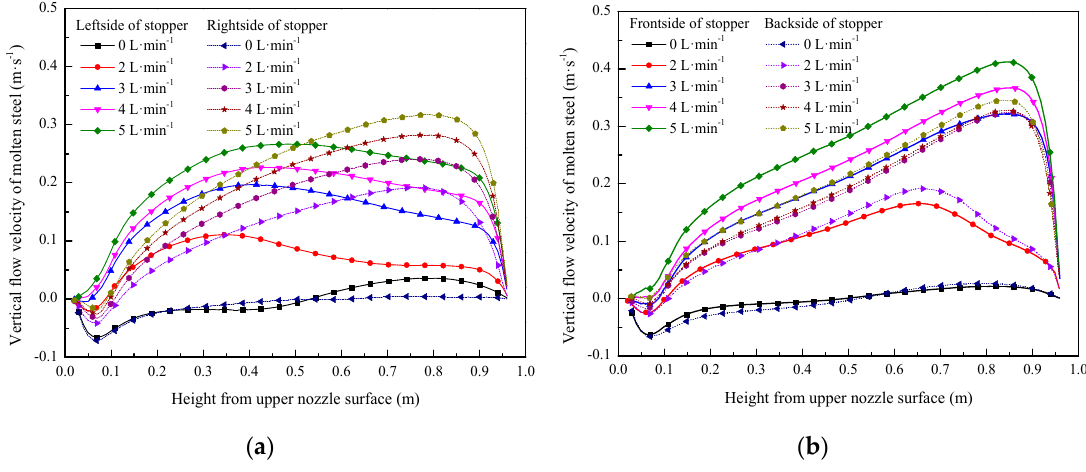
Figure 8. Vertical flow velocity of liquid steel in the vicinity of the stopper under different flow rates of argon: ( a ) left side and right side of the stopper; ( b ) front side and back sides of the stopper.